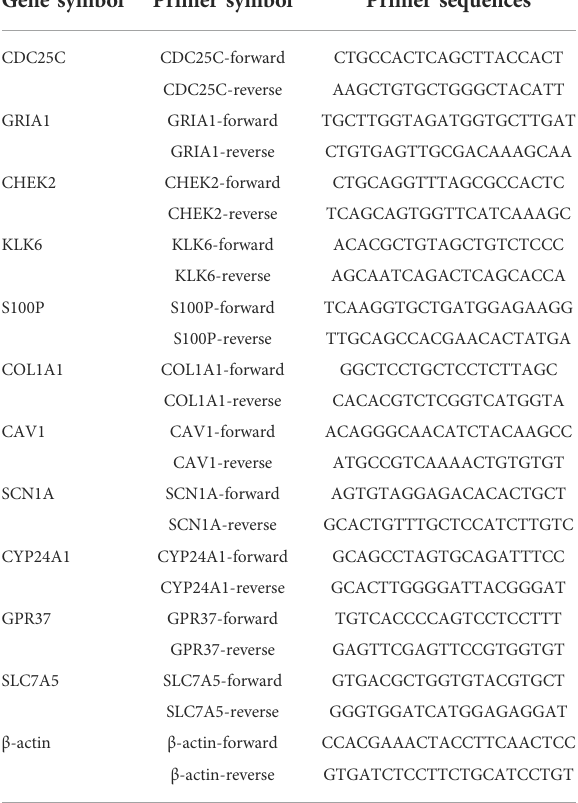
TABLE 3 The primer